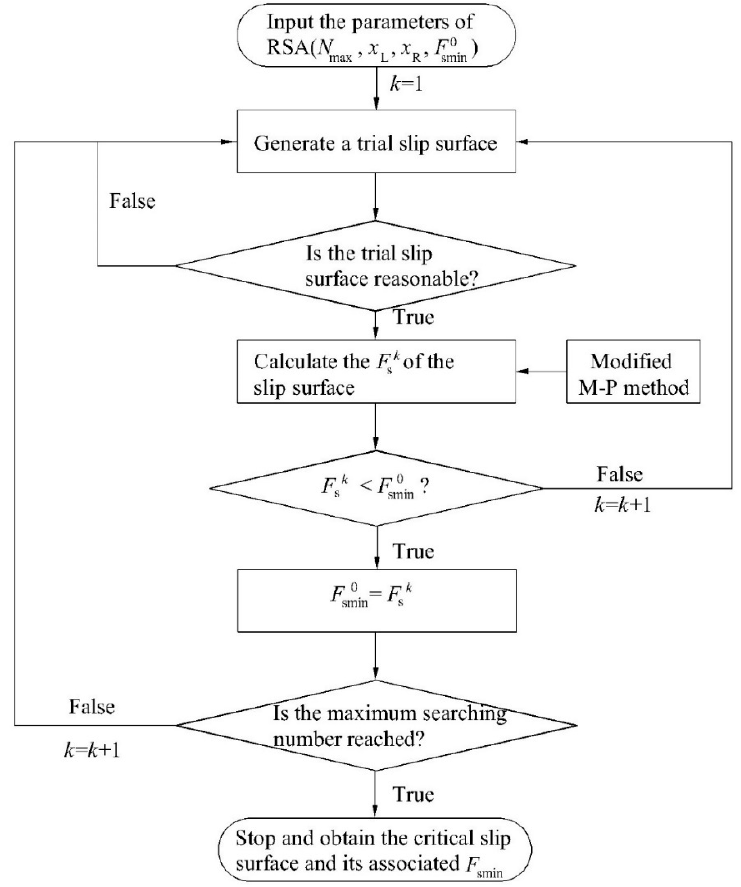
Figure 7. The flowchart of locating the critical slip surface.